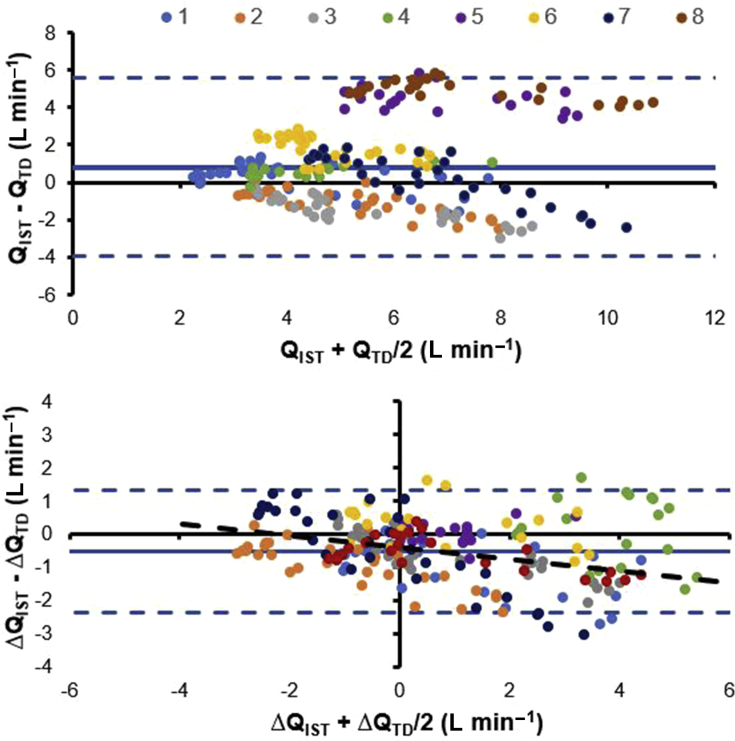
Bland–Altman analysis of the agreement between paired measurements of (a) Q˙ISTvsQ˙T and (b) ΔQ˙ISTvs ΔQ˙T from baseline. Colours represent each animal (1–8). Solid line, mean difference (bias); dotted lines, limits of agreement (LOA).